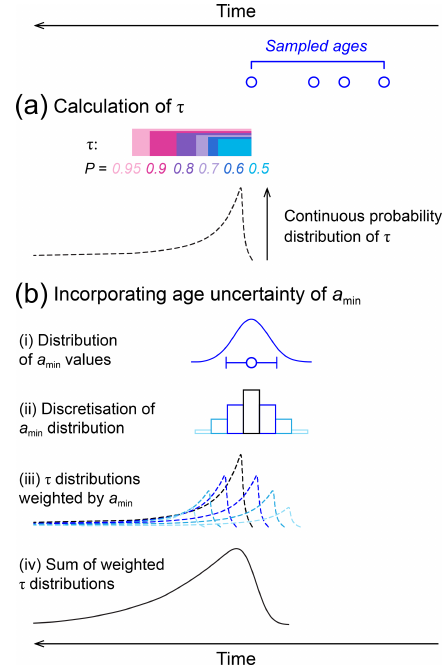
Figure 7. Schematic demonstrating how to infer the timing of sur- face abandonment from a set of sampled ages. (a) Probable aban- donment windows, τ , are calculated using Eq. (2) for discrete val- ues of P (coloured bars). A continuous probability distribution of τ is equal to the density of P within each discrete increment of τ (dashed line); this can be generated using the MATLAB tool pro- vided. (b) In reality, a min is not perfectly known and has an as- sociated age uncertainty that must be accounted for. (i) The ± 3 σ uncertainty in a min provides a distribution of probable values of a min . (ii) The distribution of a min values is discretized. In the MAT- LAB tool, we have set this discretization to be one-tenth of the 1 σ uncertainty in the youngest age, a min , to provide a highly resolved result (note that the illustration here shows much wider discretiza- tion bins for ease of visualization), but this discretization value can be modified. The discrete window of τ used to calculate the den- sity of P is set to the same width. (iii) Probability distributions of τ are calculated for each potential value of a min (as per panel a ), and weighted according to the probability distribution of a min val- ues. (iv) The weighted, temporally shifted, τ distributions are then summed to produce a final probability distribution of surface aban- donment timing that incorporates uncertainty into the youngest